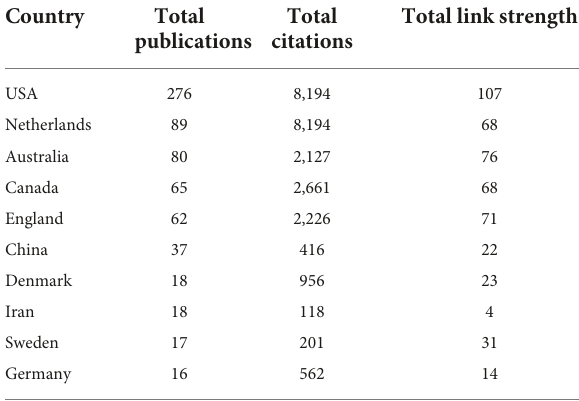
TABLE 1 Top 10 countries with the maximum articles in the